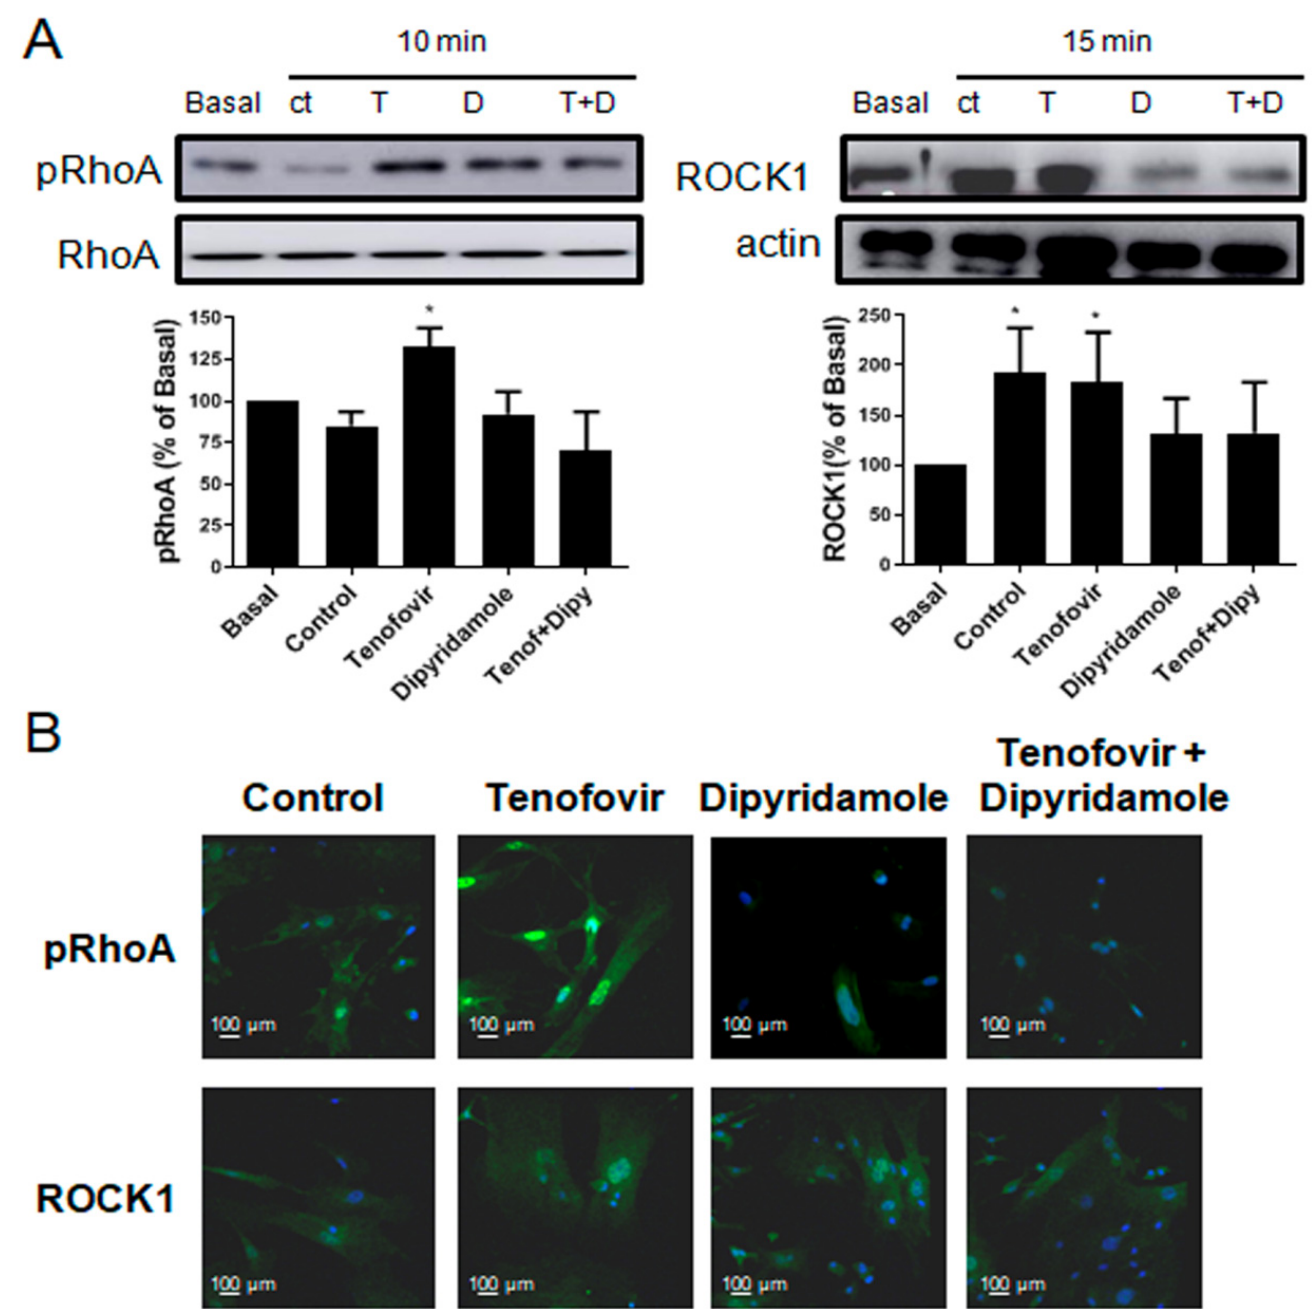
Figure 4. Phosphorylation of RhoA and ROCK1 activation were increased by tenofovir in osteoblast in WT mice. ( A ) pRhoA and ROCK1 expression were studied in osteoblast precursors in the presence of tenofovir at 1 µ M alone or with dipyridamole at 1 µ M. To normalize for protein loading, the membranes were reprobed with RhoA or actin. ( B ) pRhoA and ROCK1 (green) immunostaining in osteoblast precursors treated with tenofovir at 1 µ M alone or with dipyridamole at 1 µ M. Nuclei are shown in blue (Dapi). All images were taken at 40 × magnification, and scale bar indicates 100 µ m. * p < 0.05 ANOVA.